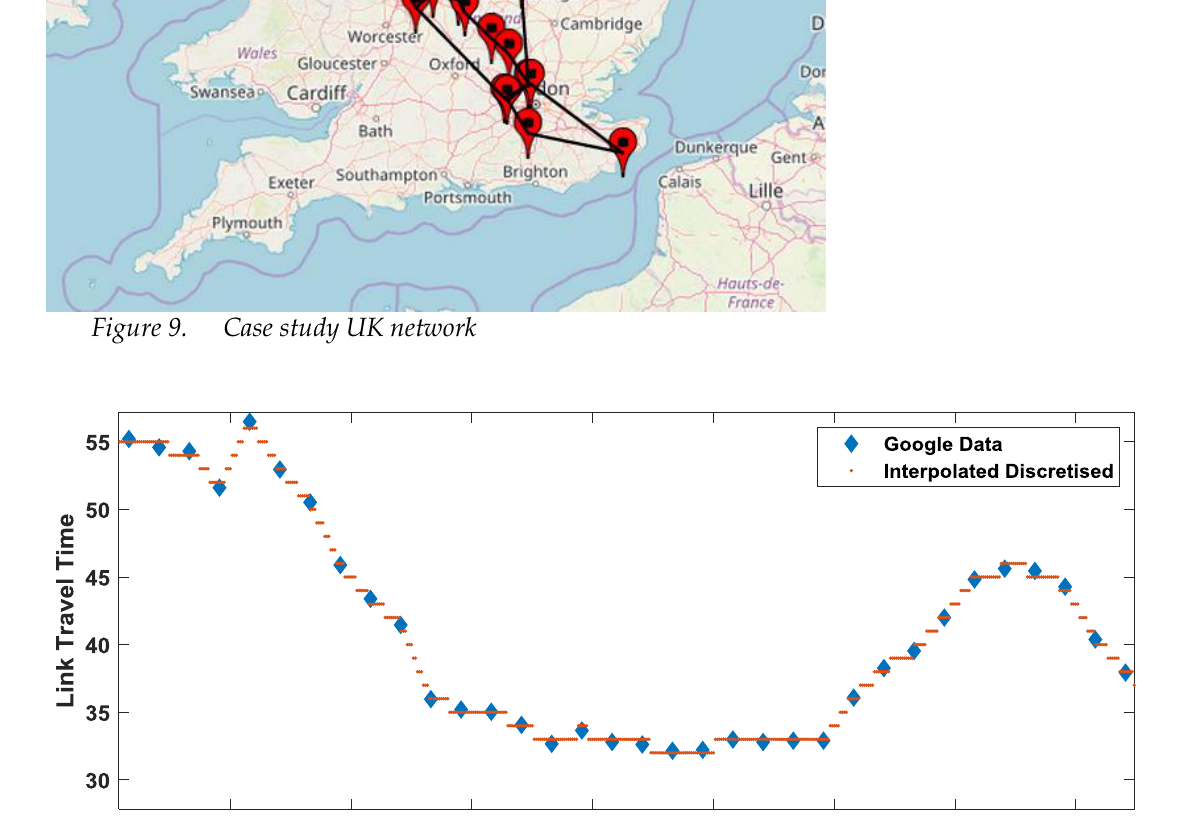
Figure 10. Interpolation and discretisation of Google link travel time data for one example link. The optimization (firstly, with respect to a single pure criterion) of departure time, link speeds, stops and route is then achieved by Dijkstra shortest path search in the ESTEN, as described in section 3.5. The performance statistics for the method are given in Table 8; the experiments were run on a standard desktop PC (Intel i7-4790 CPU 3.60GHz with 32GB RAM), written in